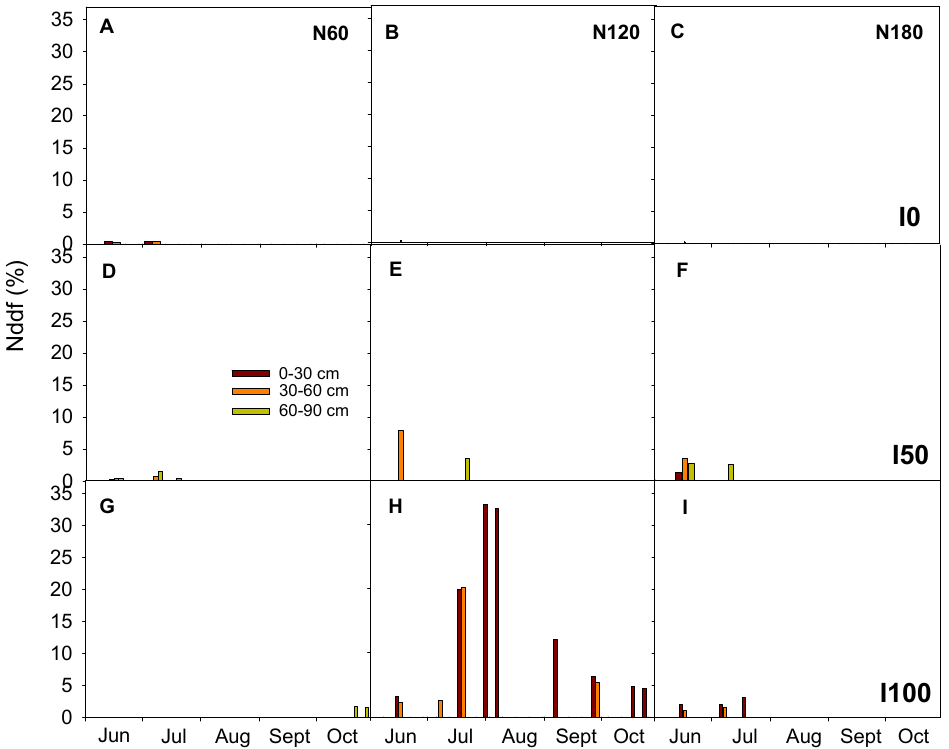
Figure 6. N from fertilization ( Ndff , %) compared to total N in soil water collected after each irrigation and rain event in porous cups in N fertilised treatments (N60, N120, N180 = 60, 120, 180 kg ha − 1 N, respectively) at different soil depths (0–30, 30–60, 60–90 cm), under no (I0) ( A – C ), deficit (I50) ( D – F ), and full (I100) ( G – I ) irrigation in sweet sorghum cv. Keller.